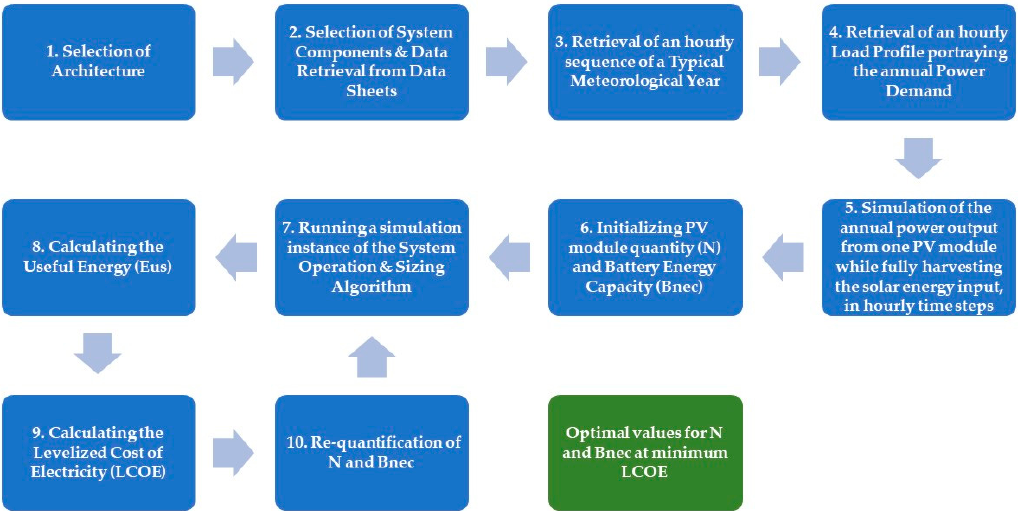
Figure 1. Flow diagram depicting the basic steps of the proposed photovoltaic (PV)–battery sizing method. Steps 7 to 10 are iterated for a specified range of PV modules and battery energy capacities, subsequently highlighting optimal values for N and Bnec at minimum levelized cost of electricity (LCOE).